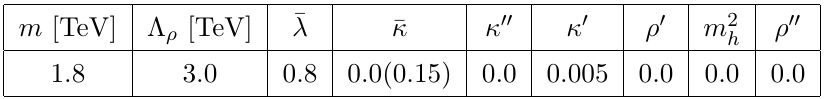
Table 1 . Tree-level parameters used for our numerical study of (cid:12)ne-tuning with respect (cid:3) t and tree-level (cid:22) (cid:26) . Numbers in parentheses are for (cid:15) + . at tree-level and others induced purely radiatively. Given the tree level value of